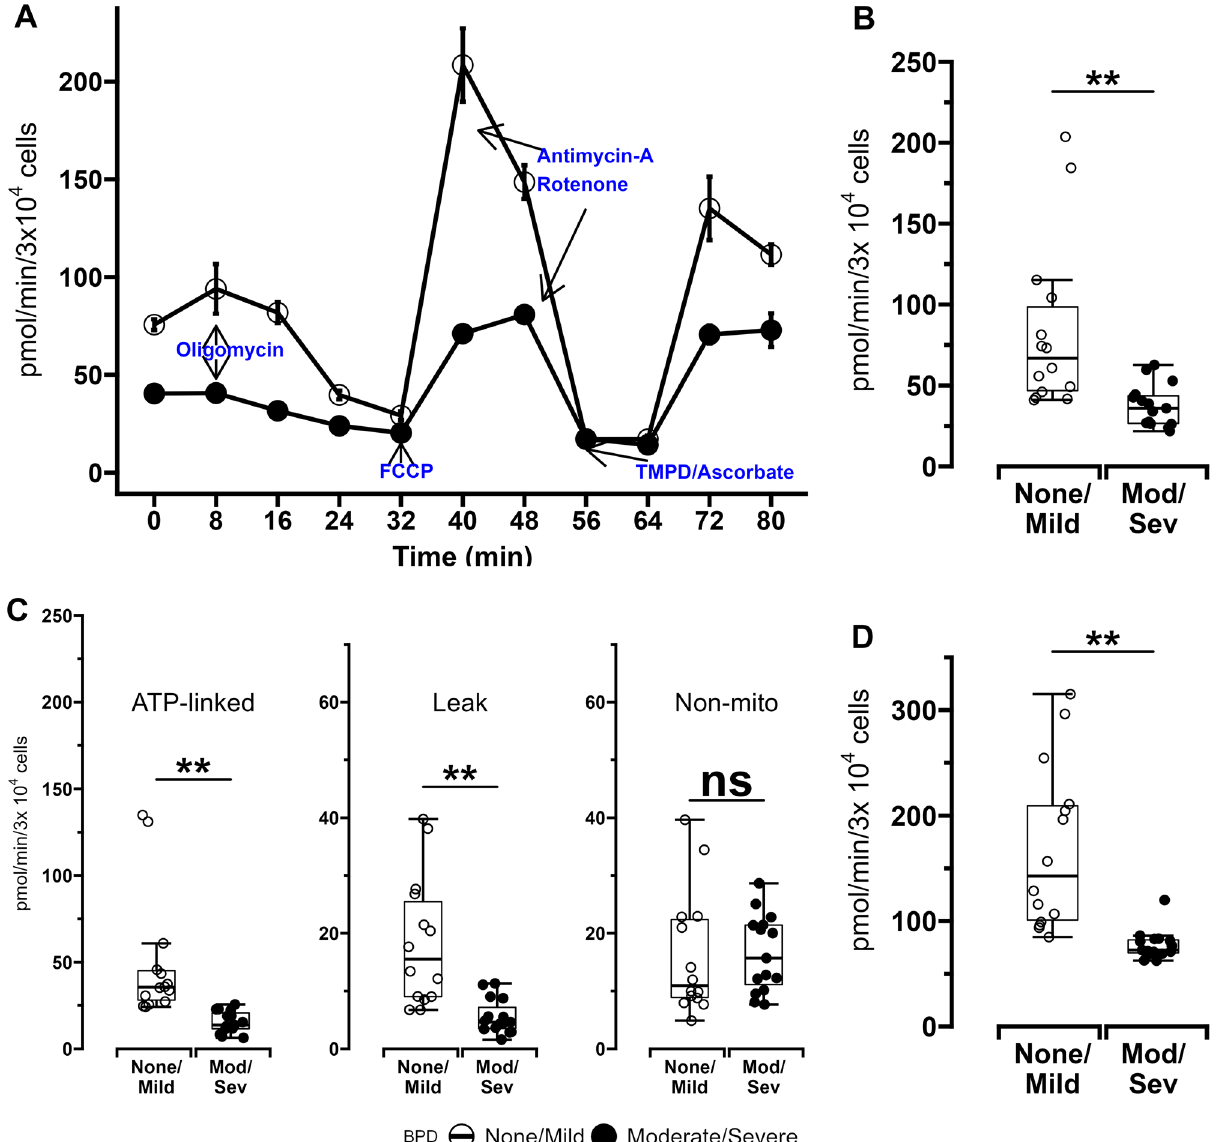
Figure 1. Oxygen consumption rates (OCR) of MSCs obtained from ELBW infants who died or developed moderate/severe BPD (Mod/Sev) and ELBW infants who survived with no/mild BPD (None/Mild). ( A ) Representative plot of a typical mitochondrial stress test conducted using a Seahorse XF96 flux analyzer. 30,000 cells were seeded per well in 96-well plates, and MSC oxygen consumption was measured in the presence of various mitochondrial effectors. ( B ) Basal OCR. ( C ) Panel with plots showing MSC ATP-linked OCR, proton leak, and non-mitochondrial OCR. ( D ) Maximal OCR measured after FCCP introduction. Data for all experiments obtained from MSCs from 15 infants with Mod/Sev BPD and 14 with No/Mild BPD. Differences were analyzed using Mann–Whitney U-test and data expressed as median [25th–75th centiles]. * and ** represent p value < 0.05 and < 0.005 respectively. NS —no significant